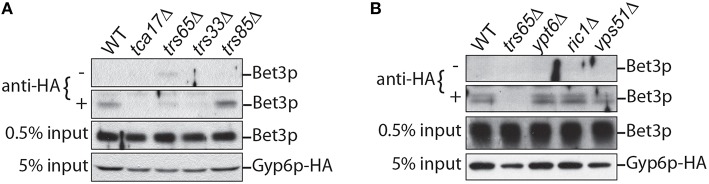
TRAPP II co-precipitates with endogenous Gyp6p-HA. (A) A small amount of TRAPP II (Bet3p is used as a marker) co-precipitates with Gyp6p-HA immunoprecipitated from yeast lysates. This interaction is disrupted in mutants (tca17Δ, trs65Δ and trs33Δ) that affect assembly of the TRAPP II but not the TRAPP III (trs85Δ) complex. (B) TRAPP II continues to interact with Gyp6p-HA when non-essential components of the Ypt6p pathway are absent. Co-immunoprecipitations were performed in strain backgrounds harboring deletions of either YPT6, RIC1 or VPS51, a Ypt6p-effector.